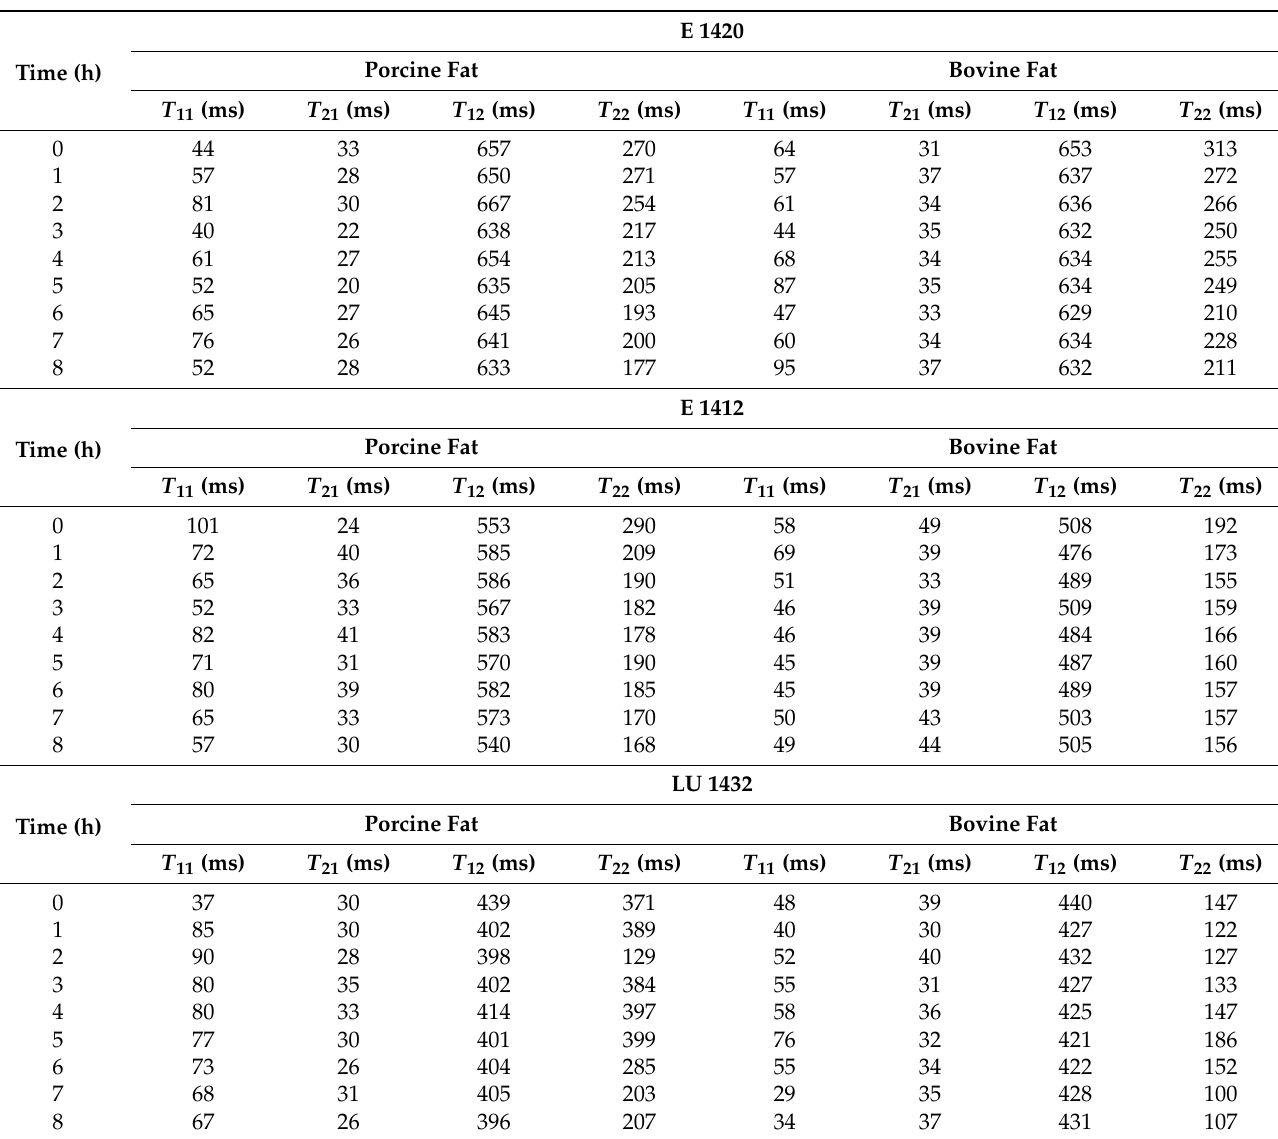
Table 2. Values of spin–lattice T 1 and spin–spin T 2 relaxation times in O/W emulsions emulsified with modified potato